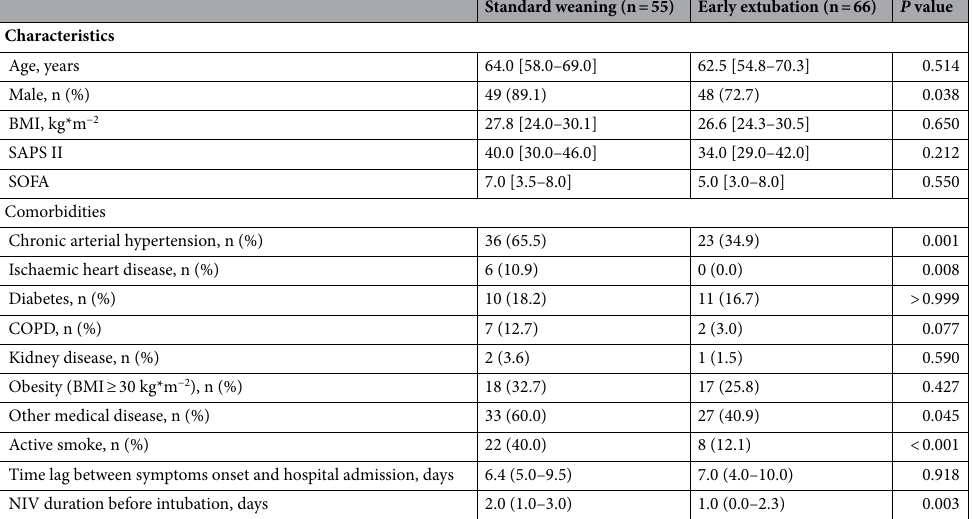
Table 1. Demographic and baseline clinical characteristics. Data are presented as number and percentage of patients (in brackets) or median and interquartile range [in brackets]. BMI, body mass index; SAPSII, simplified acute physiology score II, SOFA, sequential organ failure assessment; COPD, chronic obstructive pulmonary disease; NIV, non–invasive ventilation. P values refer to Fisher’s exact test or Mann–Whitney test.